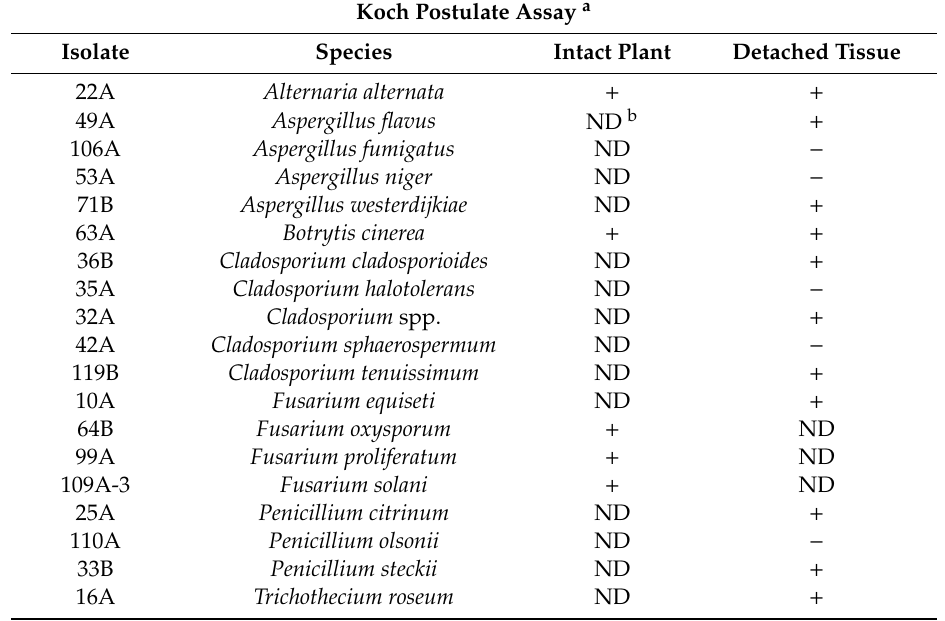
Table 1. Summary of Koch postulate assays for each fungal species.